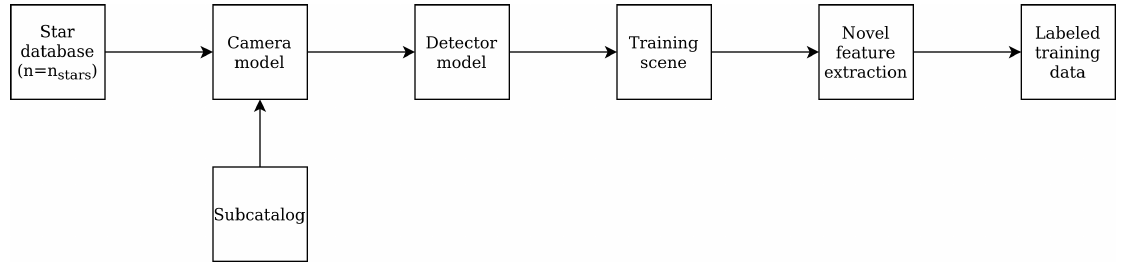
Figure 4. Training data